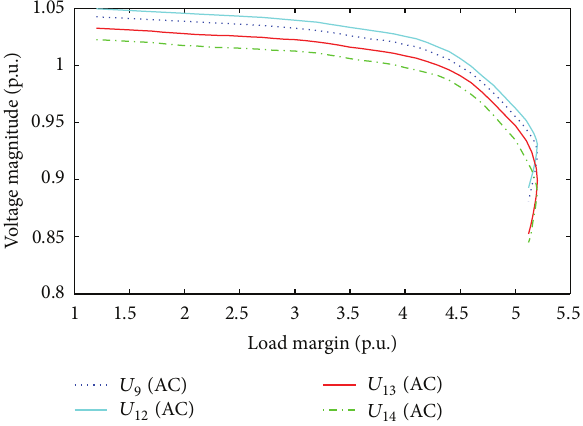
Figure 3: PV curves for IEEE-14 bus system.